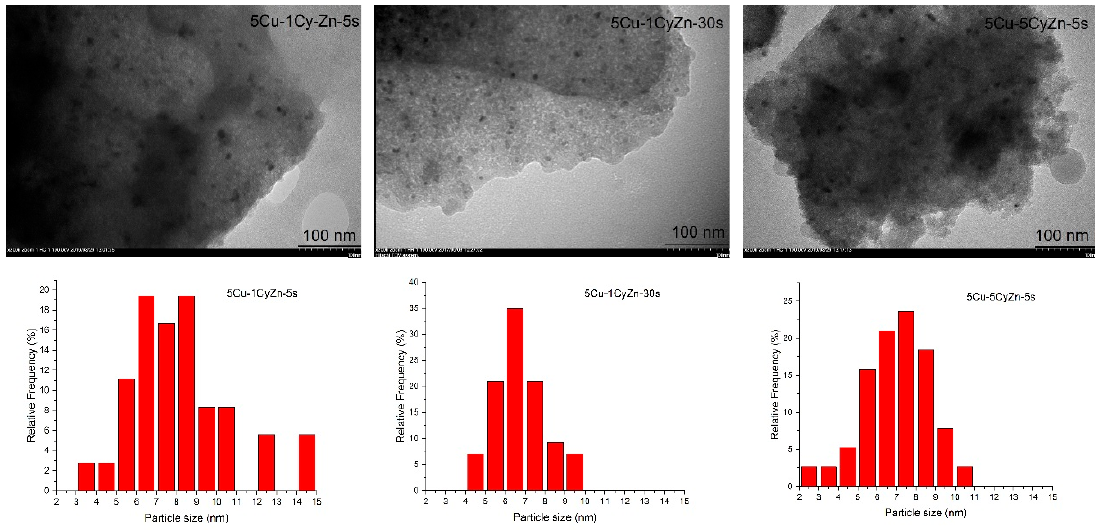
Figure 5. TEM images, particle size, and distribution of ZnO over-coated Cu / SiO 2 catalysts. Table 3. Metallic Cu particle size, dispersion, and metallic surface area of reduced catalysts.